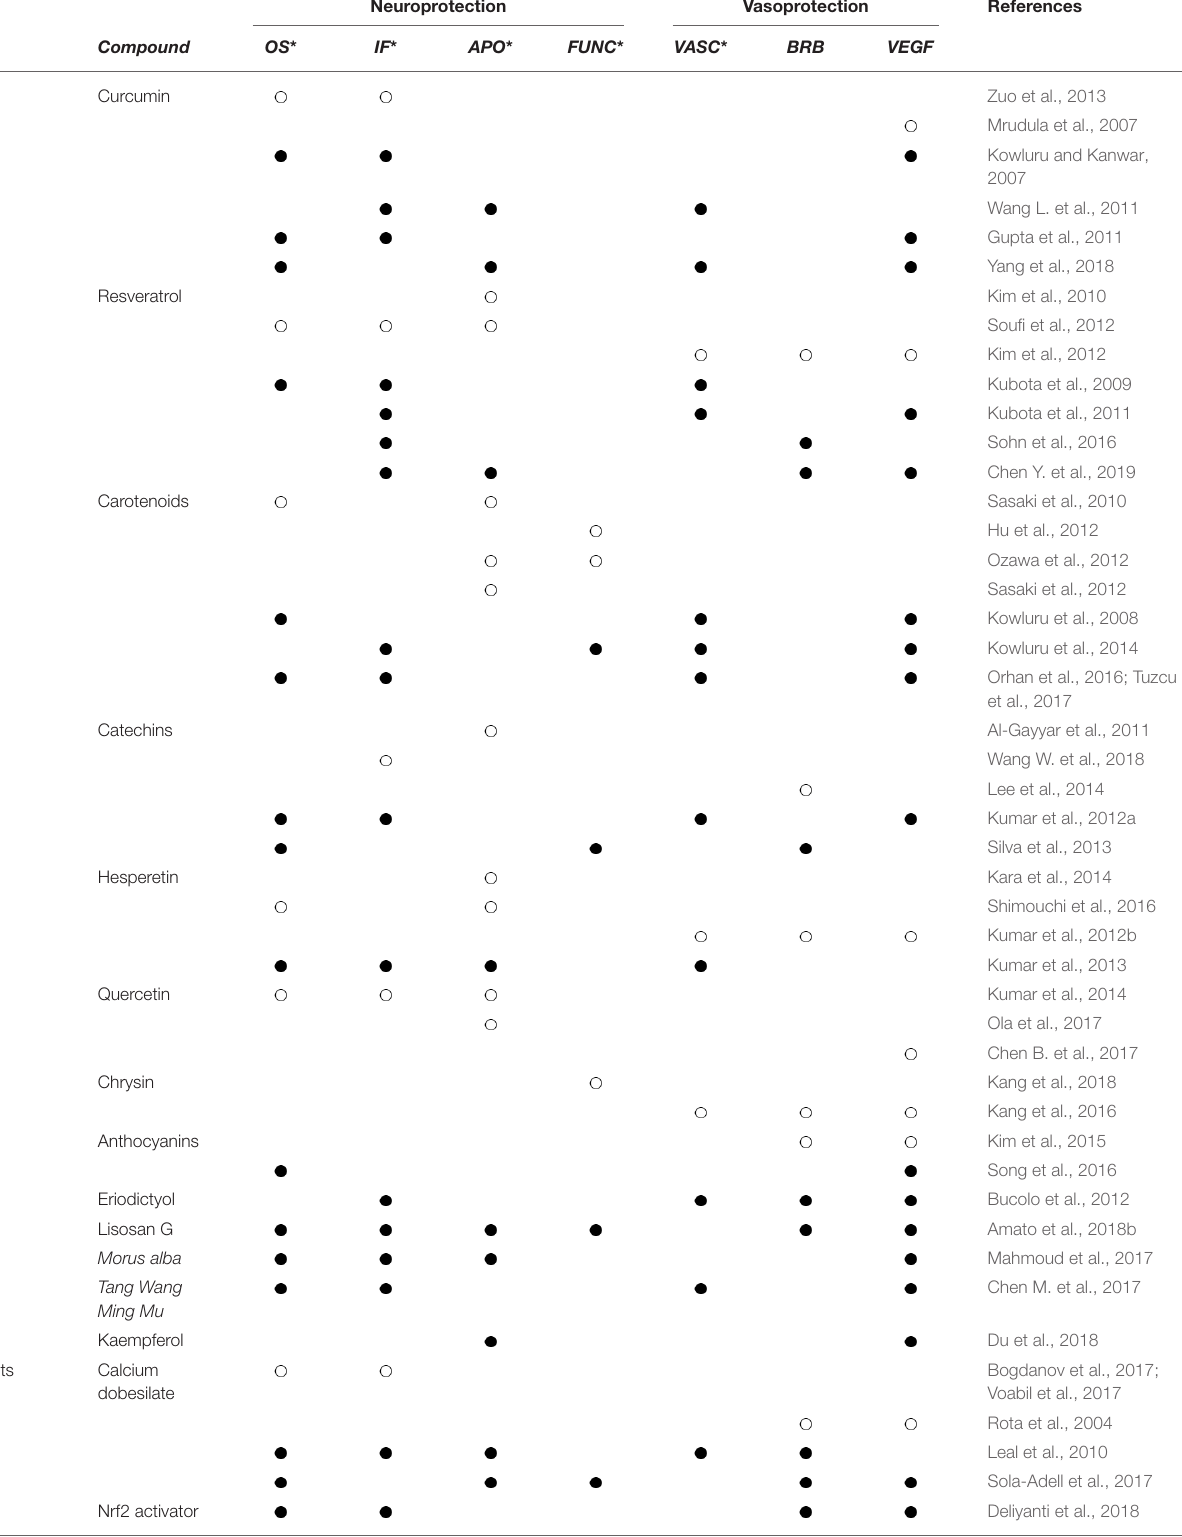
TABLE 1 | Summary of the neuroprotective and vasoprotective effects of different compounds in models of retinal